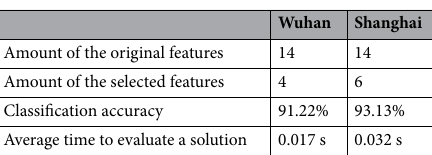
Table 7. The performance of the QBSO on the different dataset.